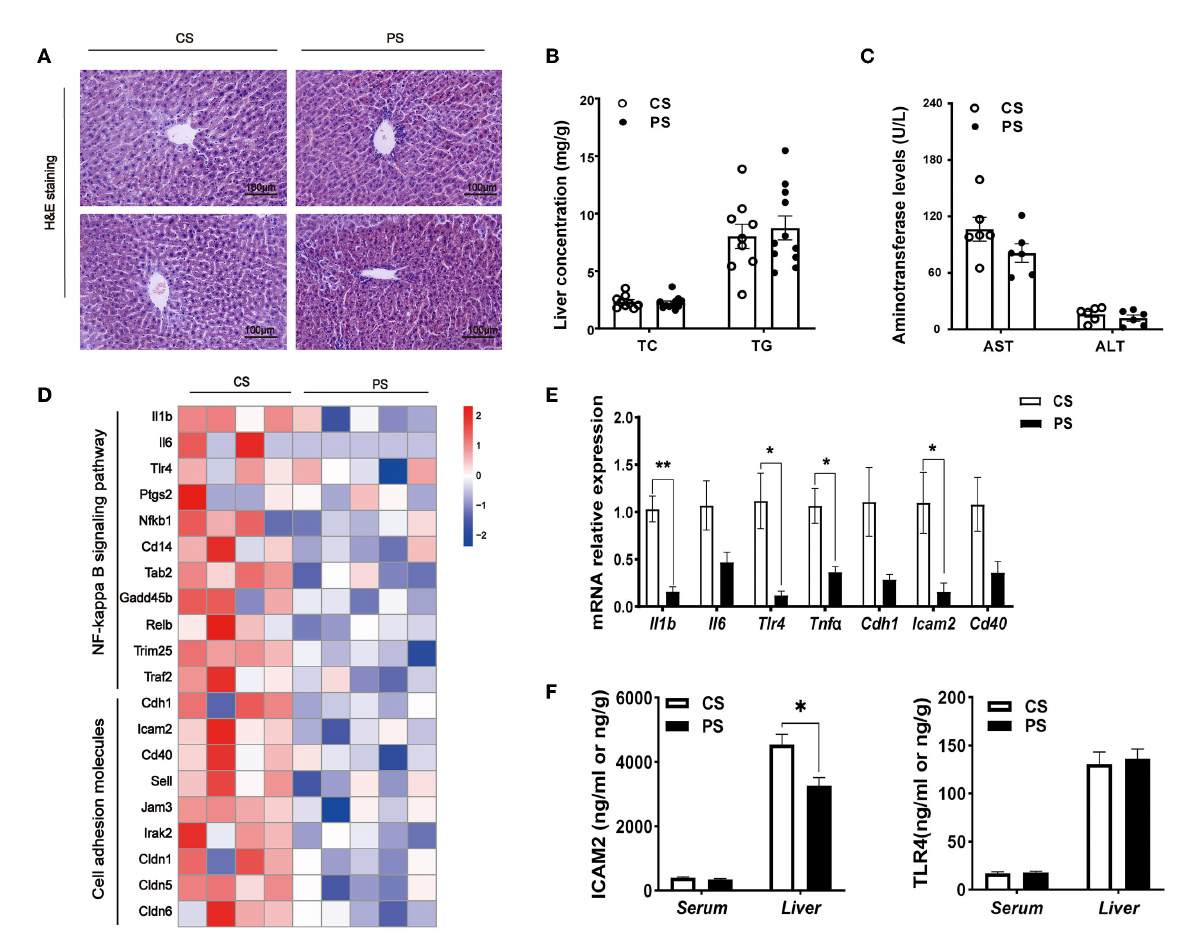
FIGURE5 Hepatic pathophysiological changes and inflammation. (A) H&E staining of the liver of mice in two groups at the end of the 28th week of the experiment. (B) TC and TG concentrations in the liver ( n = 9–11 mice/group). (C) The AST and ALT levels ( n = 5–7 mice/group). (D) Heatmap profiling the expression of genes related to inflammation in the liver ( n = 3–5 mice/group). (E) Validation of gene expression in the liver derived from RT-qPCR assay. (F) ELISA kit detecting the concentrations of ICAM2 or TLR4 in the serum and liver ( n = 4–5 mice/group). The results are presented as the mean ± SEM, representative of three independent experiments, * p < 0.05, ** p <